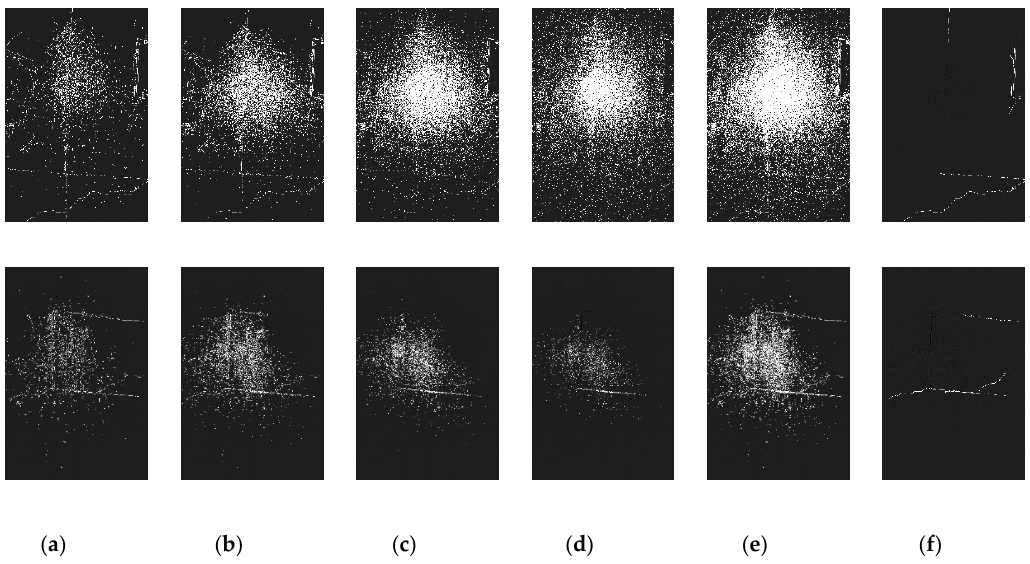
Figure 12. Detection results of steps 2 and 3 of the crack detection algorithm in Reference [18]: ( a ) detection results of step 2( σ = 8); ( b ) detection results of step 2( σ = 4); ( c ) detection results of step 2( σ = 2); ( d ) detection results of step 2( σ = 1); ( e ) detection results of step 2(multiscale fusion);